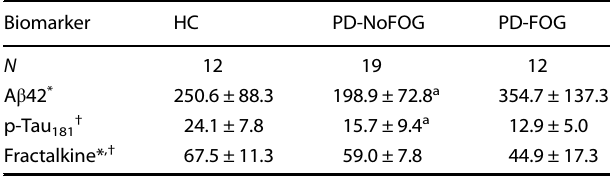
Table 2. Differential expression of CSF biomarkers across study groups.